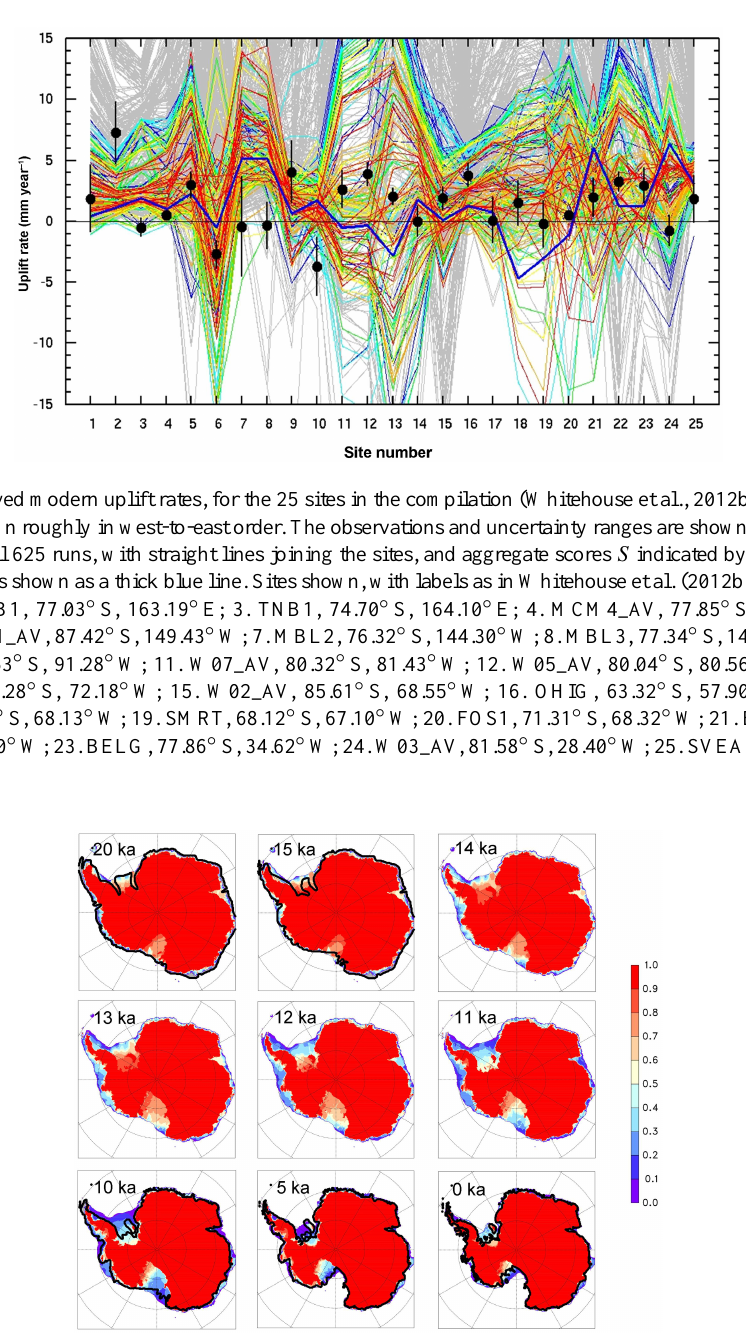
Figure D4. Score-weighted probability (0 to 1) of grounded ice vs. floating ice or open ocean at each grid point (see text), for various times over the last 20000yr, concentrating on the period of rapid retreat between 15 and 10ka. The LE and model version is essentially the same as above, except with all-Antarctic coverage to include East Antarctic variations. The quantity shown is the sum of scores S(n) for runs n with grounded ice at each grid point and time, divided by the sum of scores for all runs in the ensemble. Thick black lines in the panels for 20, 15, 10 and 5ka show grounding lines reconstructed for West Antarctica by the RAISED Consortium (2014), plotted using their vertex information (S. Jamieson, personal communication, 2015), and choosing their Scenario A for the Weddell embayment (Hillenbrand et al., 2014). For 20 and 15ka around East Antarctica, the black line is from the 20ka RAISED time slice that for the EAIS is based on Livingstone et al. (2012) and Mackintosh et al. (2014). Similarly, the modern grounding line (Fretwell et al., 2013) is shown by a thick black line for 0ka, which is also used around East Antarctica for 10 and